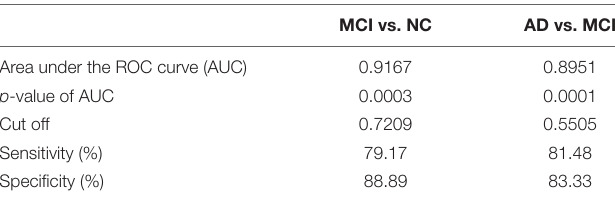
TABLE 6 | Results from receiver operating characteristic (ROC) analysis of multiple logistic regression.